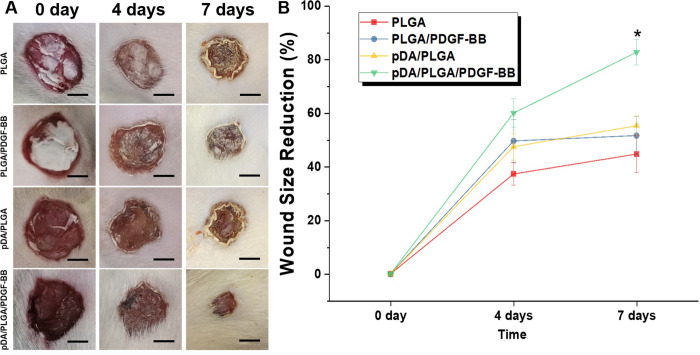
Macroscopic appearance of wounds.(A) The macroscopic appearance of the reduction in wound size in different groups of rats treated with various substitutes for 7 days. (B) The wound size reduction (%) with time. Scale bar lengths are 5 mm. These data represent the mean values of three independent experiments ± standard. *p<0.05.